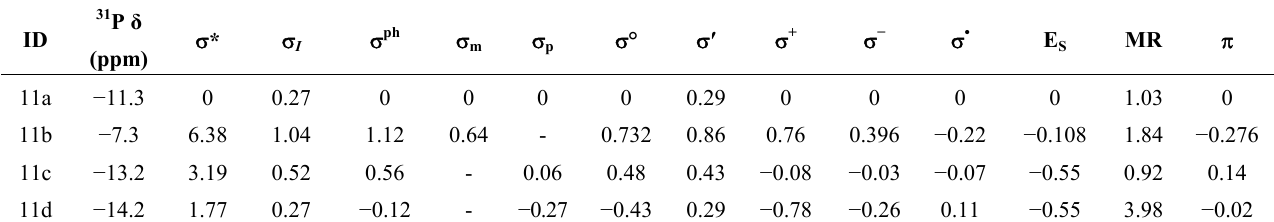
Table 1. 31 P-NMR shifts and σ values a of the aminophosphines 11a – d .